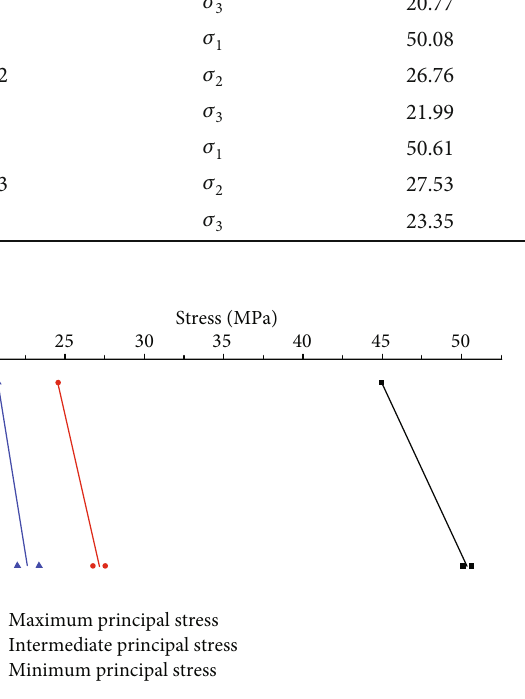
Figure 8: Relationship between in situ stress and buried